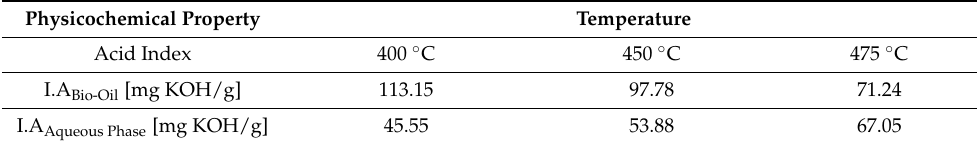
Figure 20. Effect of Ca(OH) 2 -to-MHSW ratio on the yield of bio-oil, bio-char, aqueous, and gas phases by thermal catalytic cracking of MHSW fraction (organic matter + paper) at 475 ◦ C, 1.0 atm, 5.0, 10.0, and 15.0% (wt.) Ca(OH) 2 , in laboratory scale. Table 11. Effect of temperature on the acid index of bio-oils and aqueous phase by pyrolysis of MHSW fraction (organic matter + paper) at 400, 450, and 475 ◦ C, 1.0 atm, in laboratory scale.